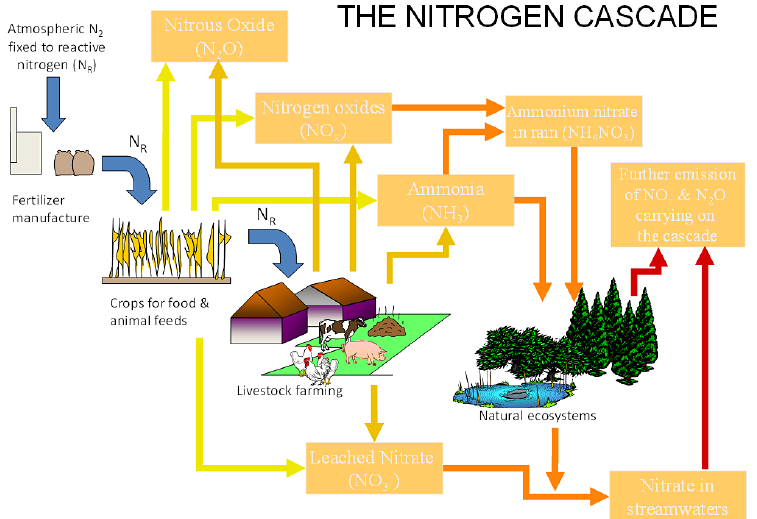
Figure 34. The nitrogen cascade adapted from Sutton et al. (2011) showing the interrelationships of nitrogen sources of importance for the production of ozone.